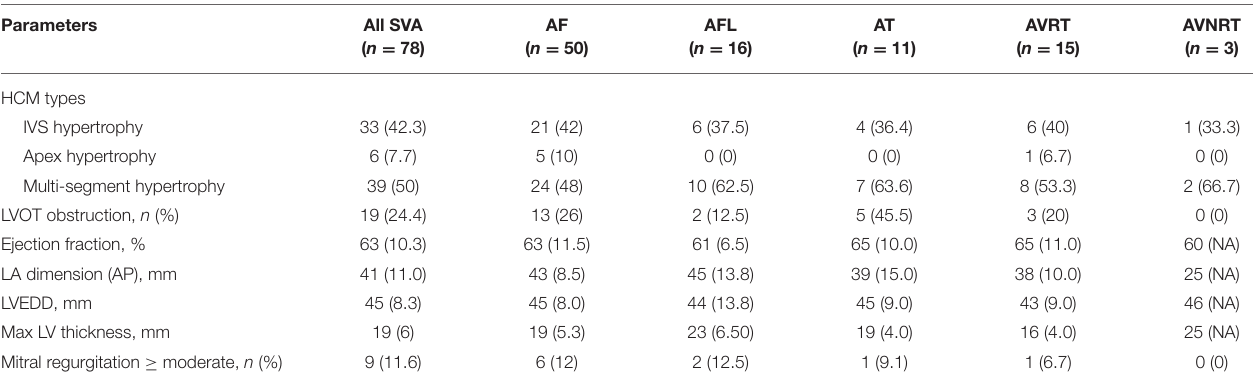
TABLE 2 | Echocardiography